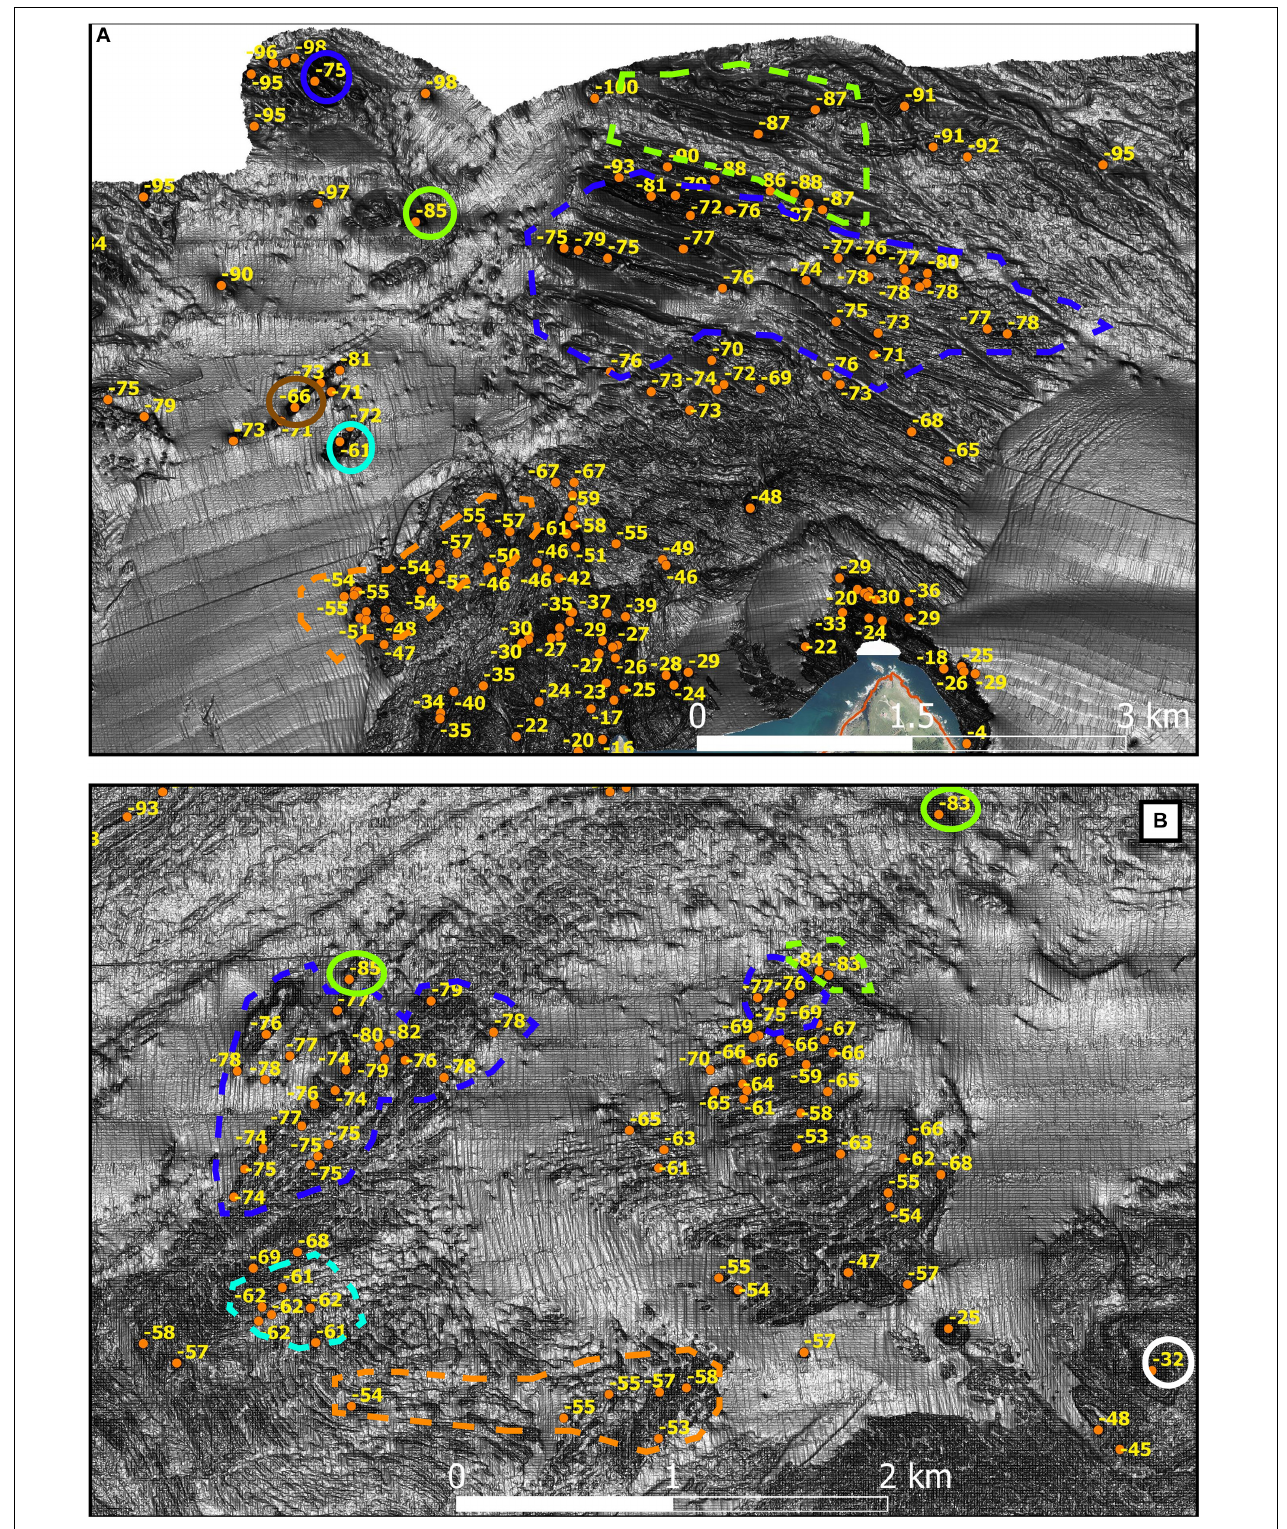
FIGURE 8 | Sea stacks distribution whose height is minimum 2 m represented by orange circles. The numbers indicate the depth of the top of the stacks. (A , B) Areas in front of Matxitxako cape and Armintza, respectively. Locations are in Figure 7A . Dotted lines highlight stacks that could be associated with previously detected submerged terraces. White, T2; Orange, T5; Light blue, T7; Brown, T8; Dark blue, T10; Light green, T11.